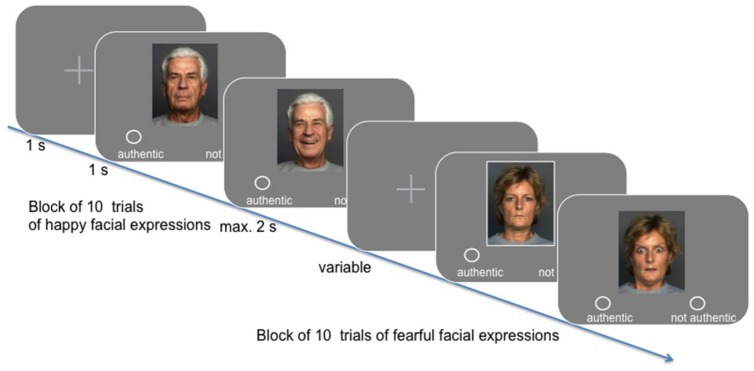
Timeline overview of the task design using exemplary stimuli from the FACES database kindly provided by Ebner et al. (2010).